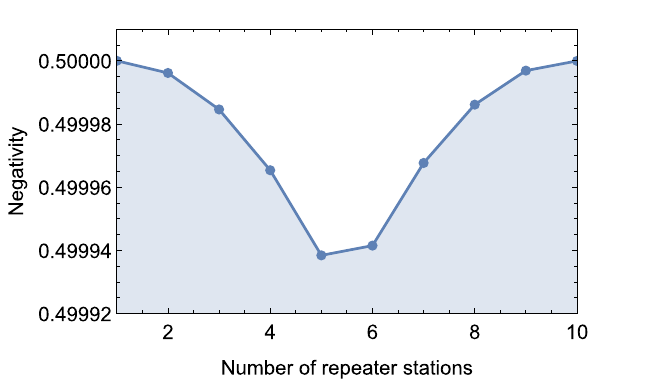
Figure 6. Negativity of the obtained state after ES over a few repeater stations for demonstrating one of the periodic turning